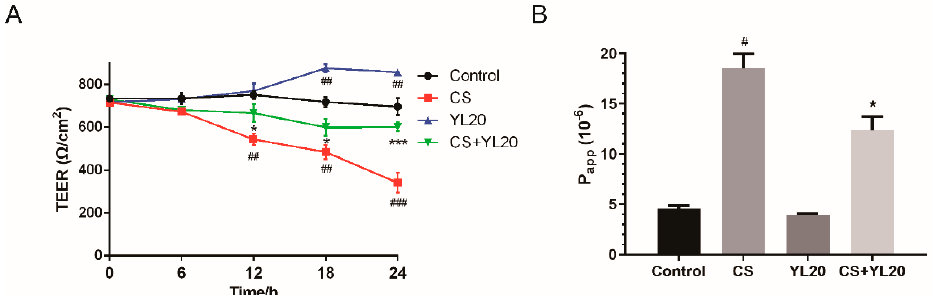
Figure 4. Effects of L. salivarius YL20 on TEER and membrane permeability of C. sakazakii -infected Caco-2 monolayers. ( A ) During co-incubation of Caco-2 monolayers with YL20 and C. sakazakii , TEER was measured at 0, 6, 12, 18, and 24 h. ( B ) Permeability of Caco-2 monolayer to FITC-dextran